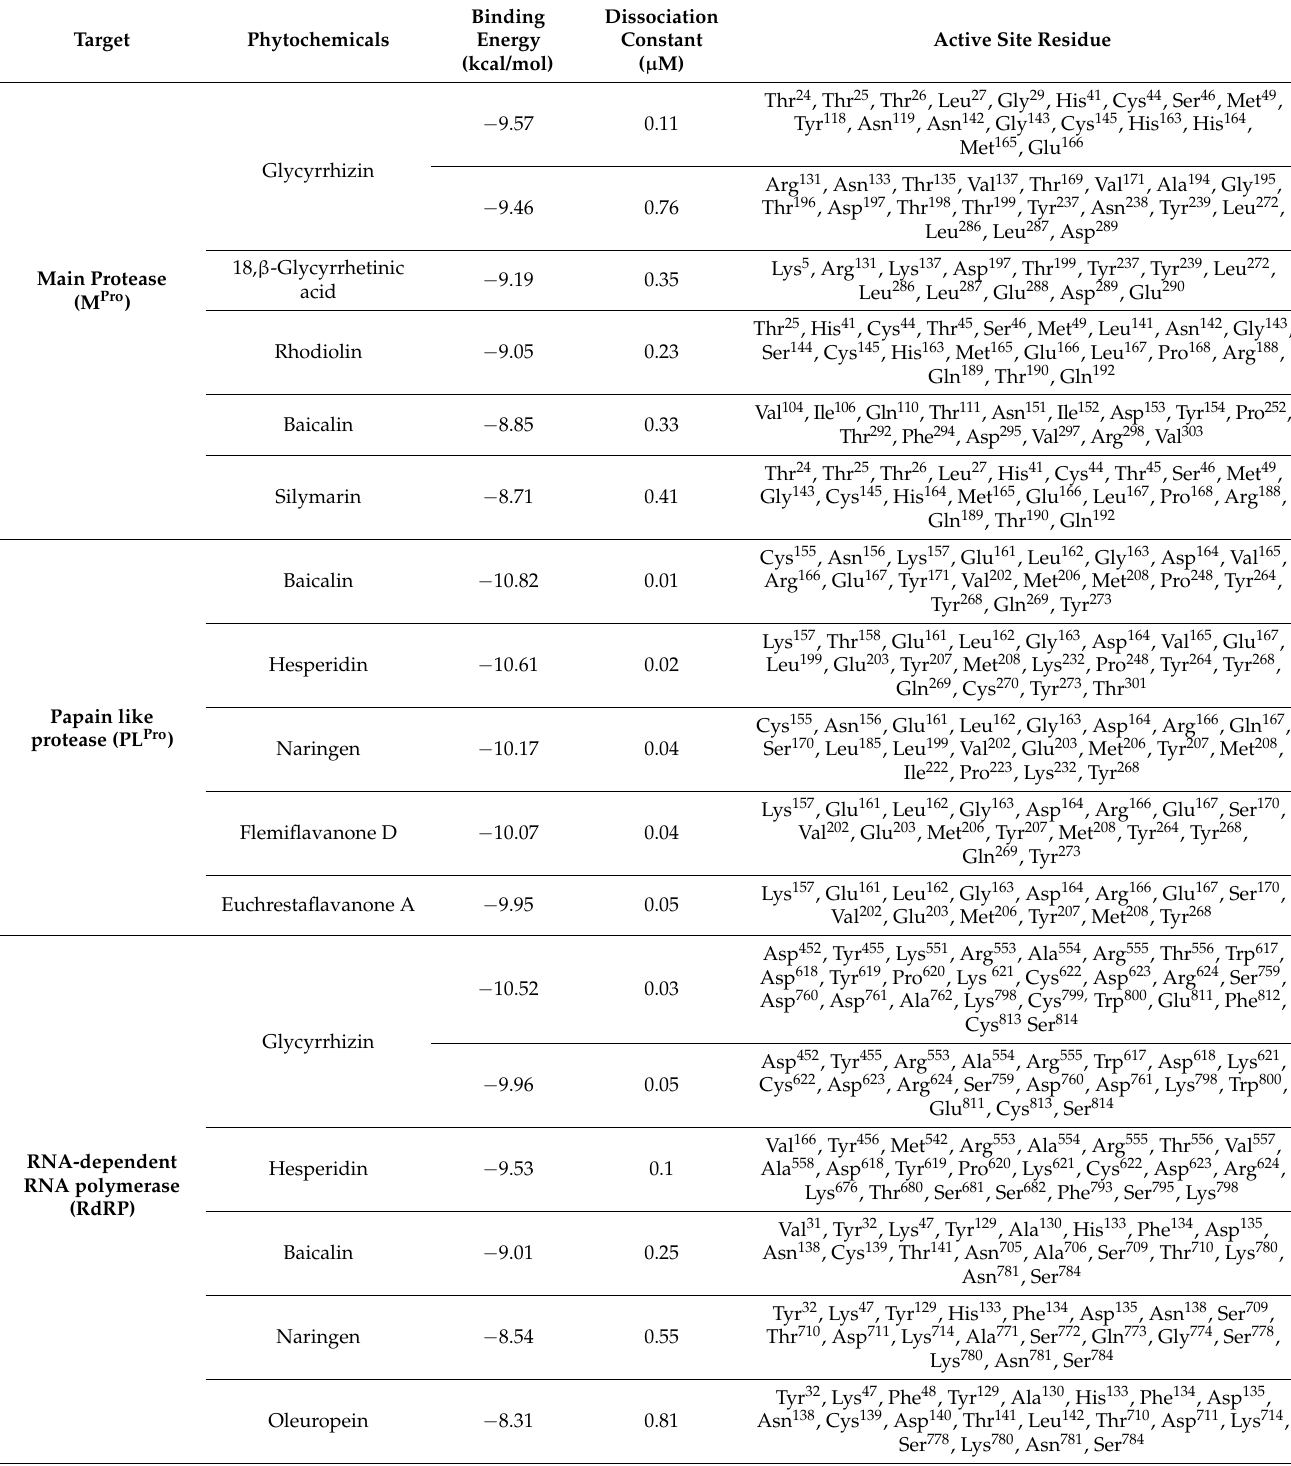
Table 1. The best five docked ligands to Main Protease, Papain-like protease, RNA-dependent RNA polymerase, Spike Glycoprotein and Helicase, E-Channel; their binding energies, dissociations constants and active site